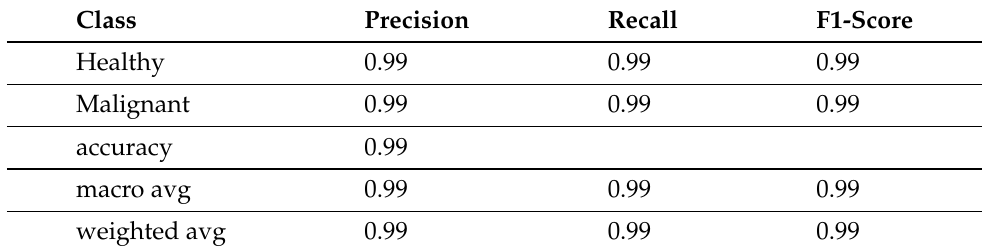
Table 6. Detailed results of Healthy and Malignant classes in skin disease detection.